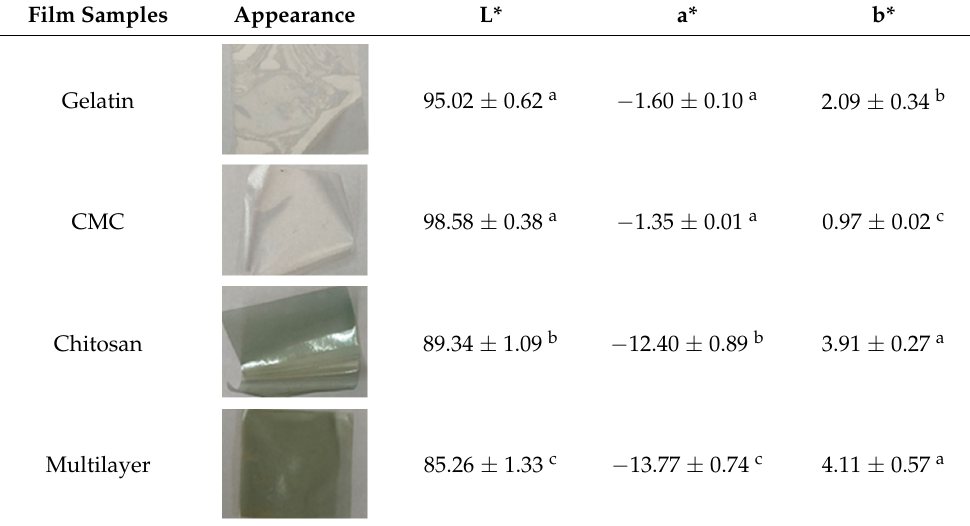
Table 3. The appearance and color attributes of the monolayer and multi-layer films incorporated with RCE.